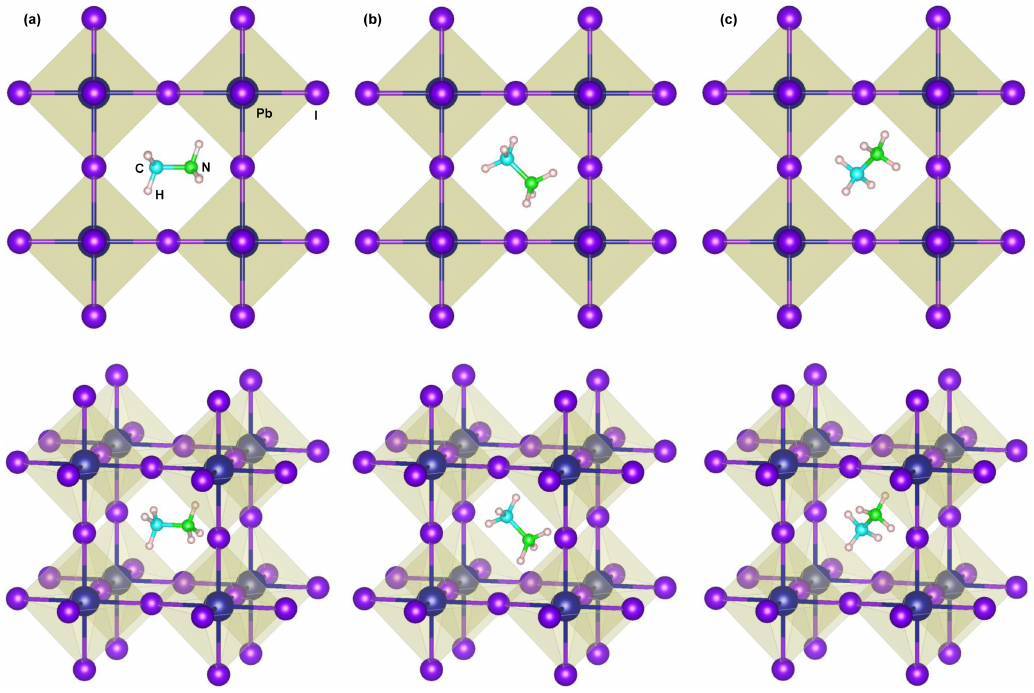
Figure 7: Local structural models of cubic CH 3 NH 3 PbI 3 . CH 3 NH 3 ions are set along the (a) [100], (b) [110], and (c) [111] directions.